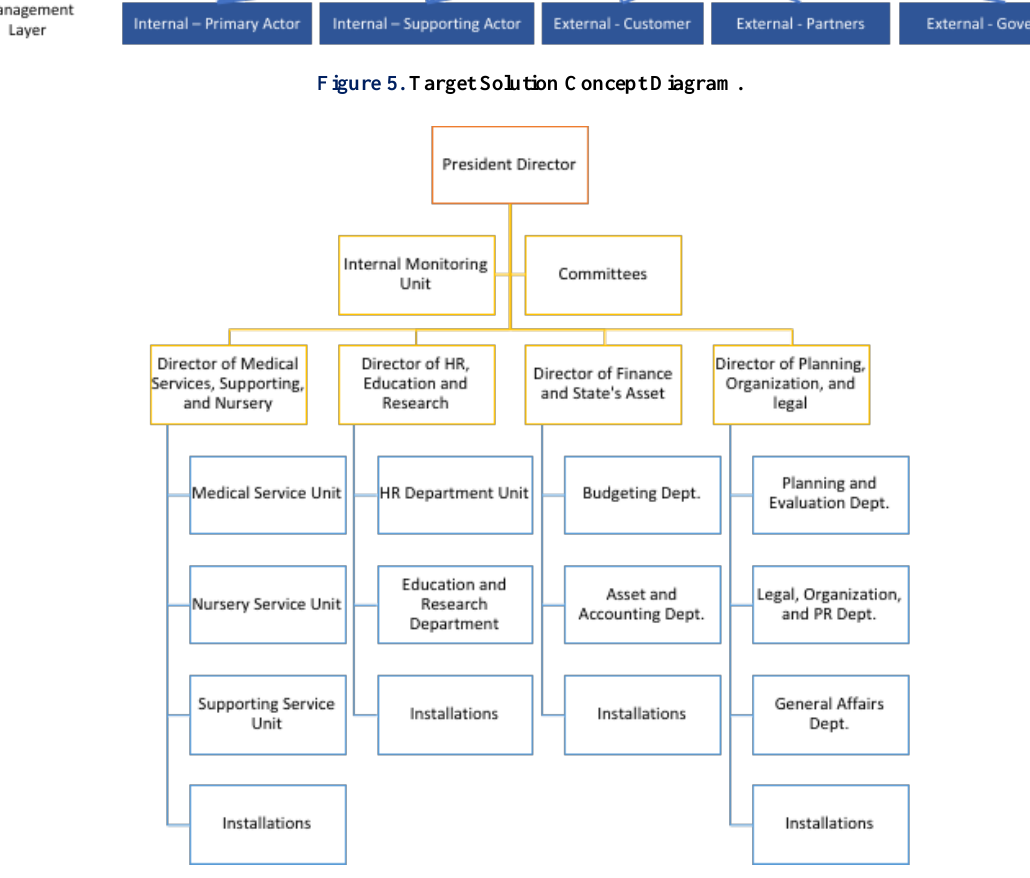
Figure 6. Organization Structure of RSK Dharmais